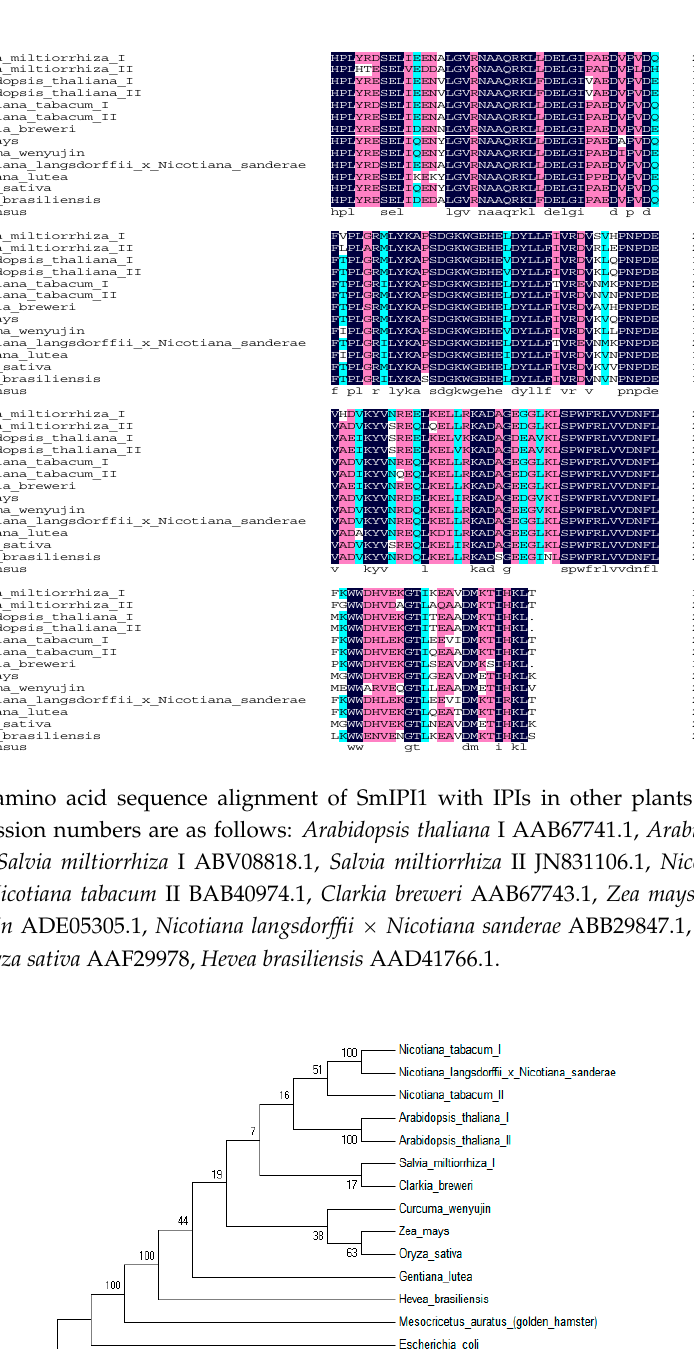
Figure 3. The phylogenetic tree was built based on the partial IPI amino acid sequences of different species using the neighbor-joining method. The amino acid sequence accession numbers are as follows: